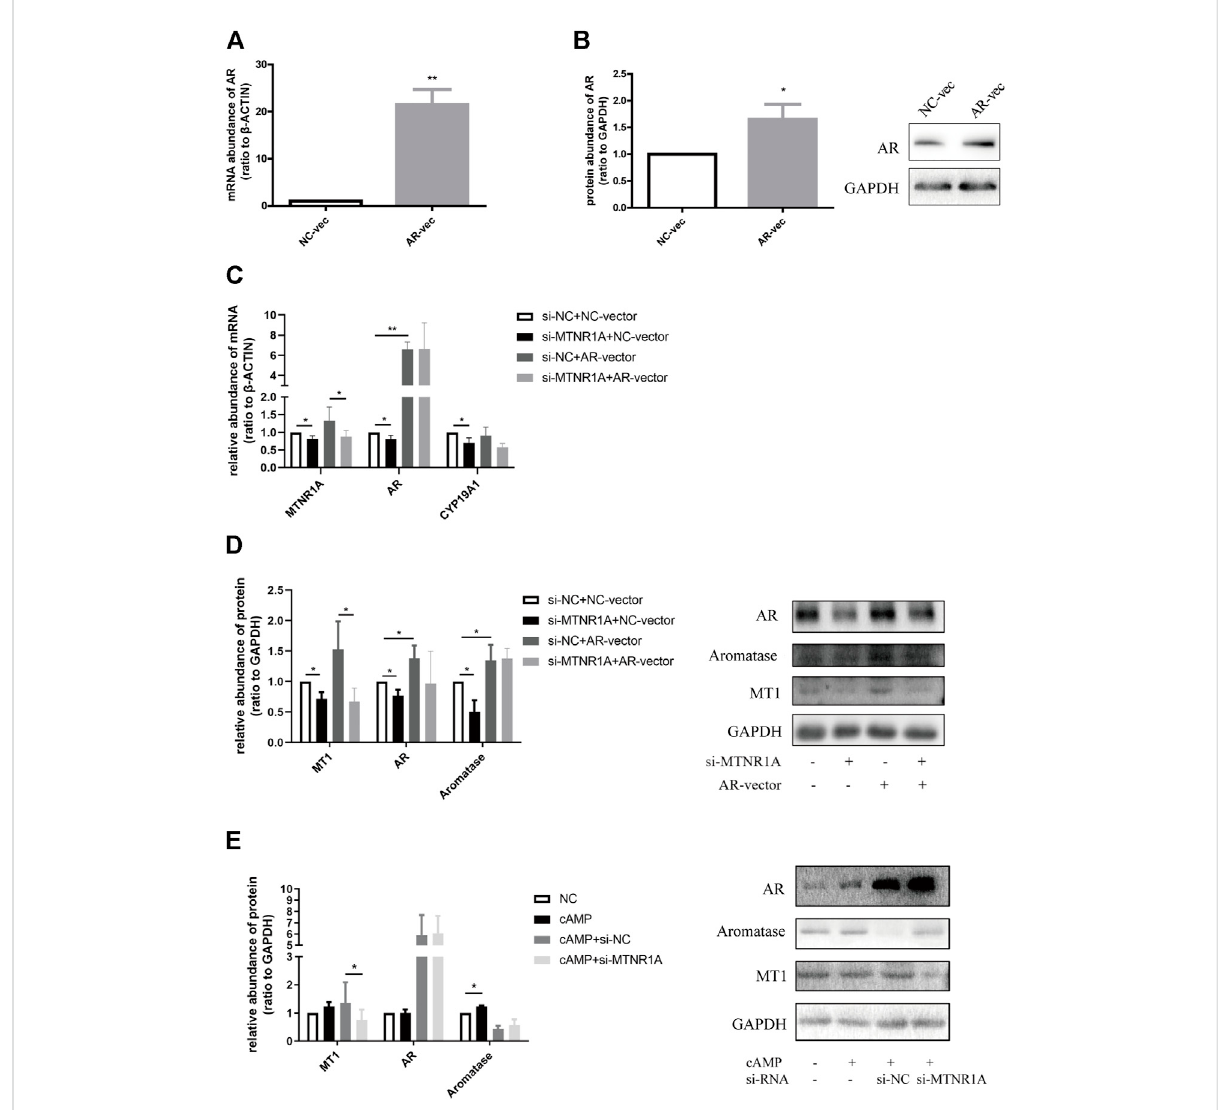
FIGURE 8 MTNR1A regulated aromatase expression through AR and PKA/cAMP pathway. (A,B) Ef fi ciency of AR -overexpression in mRNA and protein levels, respectively. (C,D) mRNA and protein abundance of MTNR1A , AR , and CYP19A1 after MTNR1A -knockdown and AR -overexpression, respectively. (E) ProteinabundanceofMT1,AR,andaromataseafter MTNR1A- knockdownandincubationwith100 μ mol/LcAMPfor24 h.Valuesare expressedasmeans±SEM.Theseresultsarerepresentativeofatleastthreeindependentexperiments.Signi fi cantdifferencesbetweenthetwo groups are indicated by asterisks (* p < 0.05 and ** p <